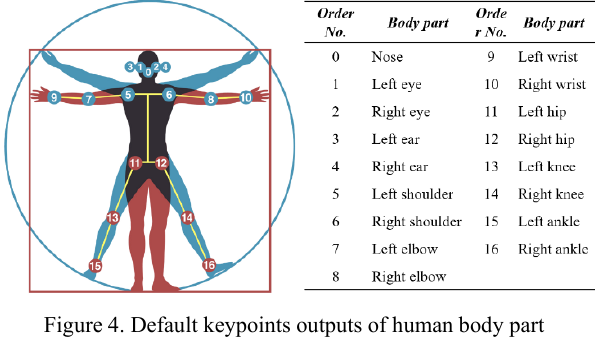
Figure 4. Default keypoints outputs of human body part in